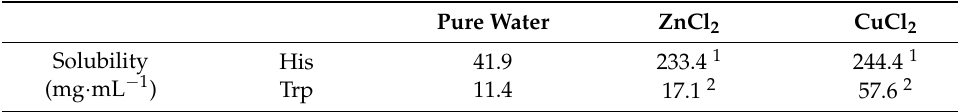
Pure Water ZnCl 2 CuCl 2